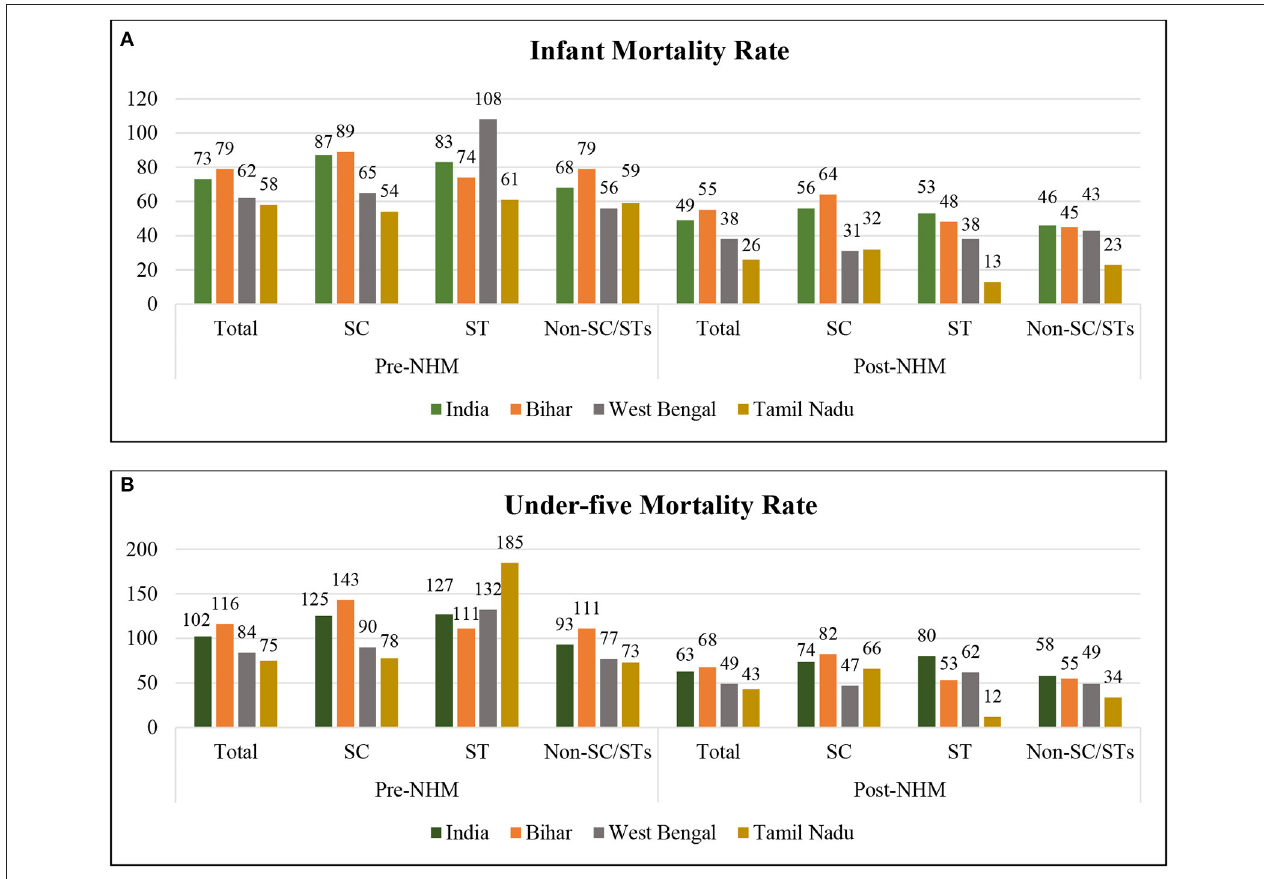
FIGURE 1 | Social gap in (A) infant mortality rate (IMR) and (B) under-five mortality rate (U5MR) during the pre- and post-National Health Mission (NHM) periods. Authors estimated IMR and U5MR per 1,000 live births for the 5-year period preceding the survey. Average death rates have been calculated. For the pre-NHM period (1992–1999), NFHS 1 and 2, and for post-NHM period (2005–2016), NFHS 3 and 4 have been